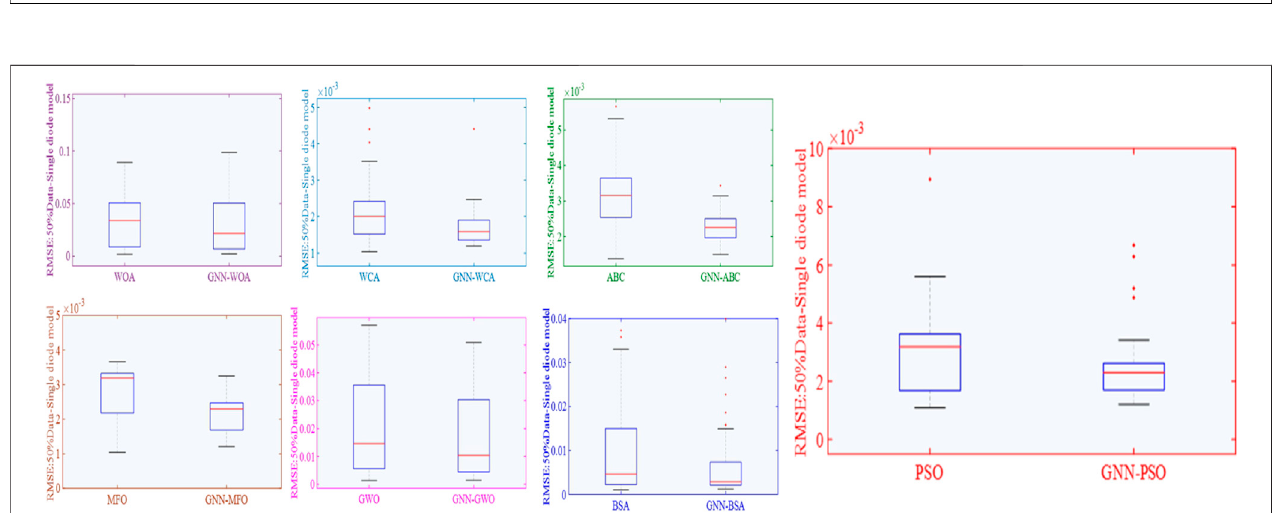
FIGURE 7 | Boxplot of RMSE under different data for the SDM under 50%